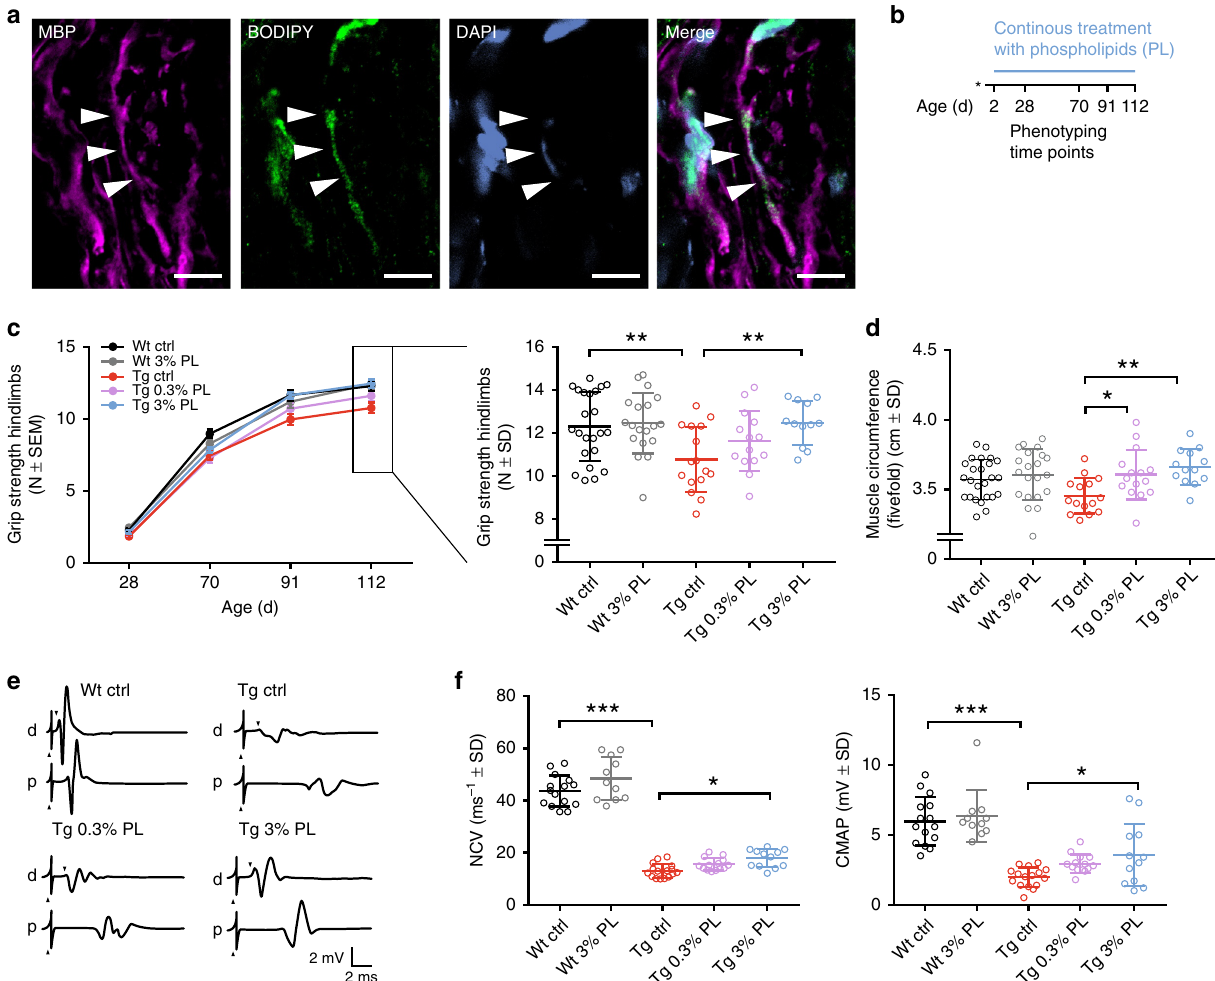
Fig. 2 Phospholipid therapy in CMT rats ameliorates neuropathy. a BODIPY-phosphatidylcholine (BODIPY-PC, green) was injected into the tail vain of a 15-day-old CMT rat. Shown is a longitudinal confocal microscopic image of a sciatic nerve cryo section 7 days post injection. Myelinated fi bers (MBP, magenta) display myelin sheaths with incorporated BODIPY-PC (arrow heads, scale = 10 µ m). b Treatment scheme. CMT rats (Tg) and wild-type rats (Wt) were fed with either normal diet or a food enriched with 0.3 or 3% phospholipids (PL, see Methods section for details) from postnatal day (P) 2 to P112. c Grip strength measurements at the age of 28, 70, 91, and 112 days (left panel). For the 112 days time point, the individual data points are shown (right panel). Wt control rats (Wt ctrl, black, n = 22) and Wt rats fed with 3% PL (Wt 3% PL, gray, n = 19) displayed normal motor performance. Tg control rats (Tg ctrl, red, n = 16) are weaker compared with Wt. Tg rats treated with 0.3% PL (Tg 0.3% PL, purple, n = 15) and 3% PL (Tg 3% PL, blue, n = 13) display a stepwise improvement in grip strength (one-way ANOVA). d The circumference of the muscles of the lower forelimbs of CMT rats is increased by phospholipid therapy (Wt ctrl, black, n = 25; Wt 3% PL, gray, n = 21; Tg ctrl, red, n = 15; Tg 0.3% PL, purple, n = 15; Tg 3% PL, blue, n = 13, one-way ANOVA, Sidak ’ s post test). e Representative traces of electrophysiological recordings at the tail motor nerve at P112. Wild-type rats display a shorter distal motor latency (DML, arrow head down, stimulation artifact is demarcated by arrow head up) and bigger compound muscle action potential (CMAP) amplitudes after distal (d) and proximal (p) stimulation when compared with transgenic control rats (Tg ctrl). Treatment with PL (0.3 and 3%) increases CMAP. f Quanti fi cation of ( e ). Tg control rats (Tg ctrl, red, n = 16) display reduced nerve conduction velocities (NCV, left panel) and CMAP amplitudes (right panel) when compared with Wt control rats (Wt ctrl, black, n = 15) and Wt rats treated with 3% PL (Wt 3% PL, gray, n = 11). Phospholipid treatment in Tg rats (Tg 0.3% PL, purple, n = 14; Tg 3% PL, blue, n = 12) increases NCV and CMAP (one-way ANOVA, Sidak ’ s post